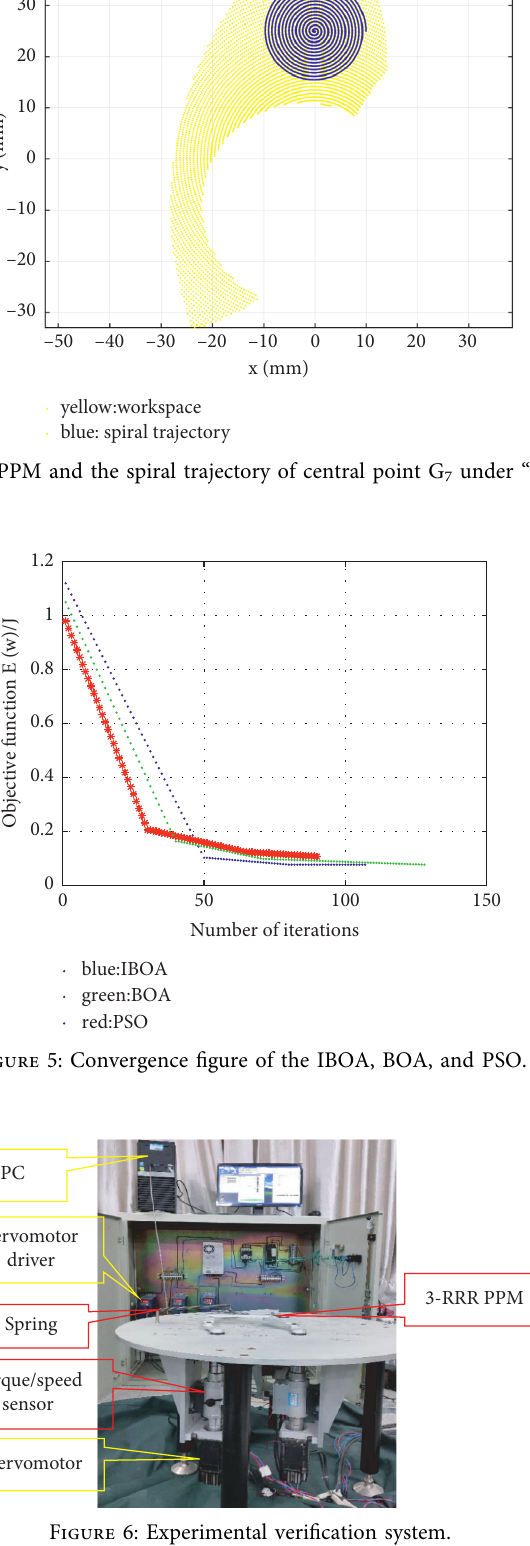
Figure 6: Experimental verification